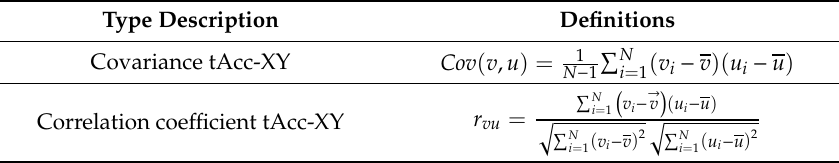
Table 2. Correlation feature between signal pairs of the x -axis and y